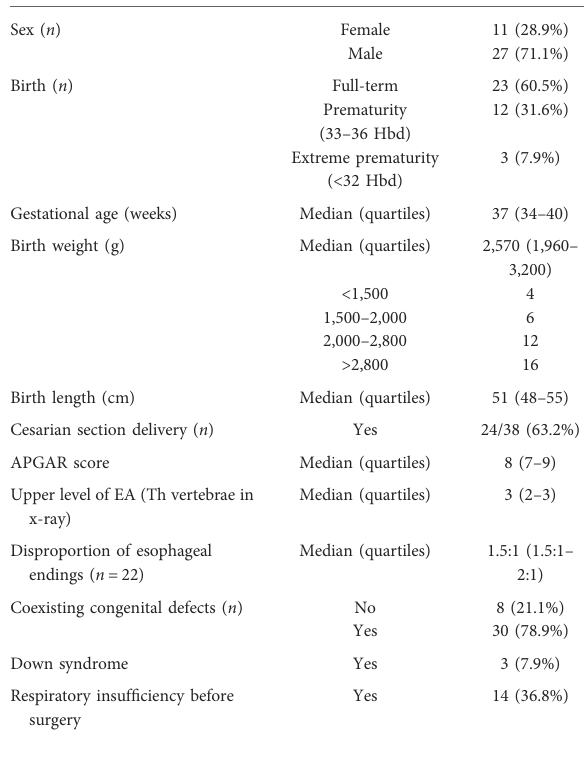
TABLE 2 Demographic and clinical data of patients included in the